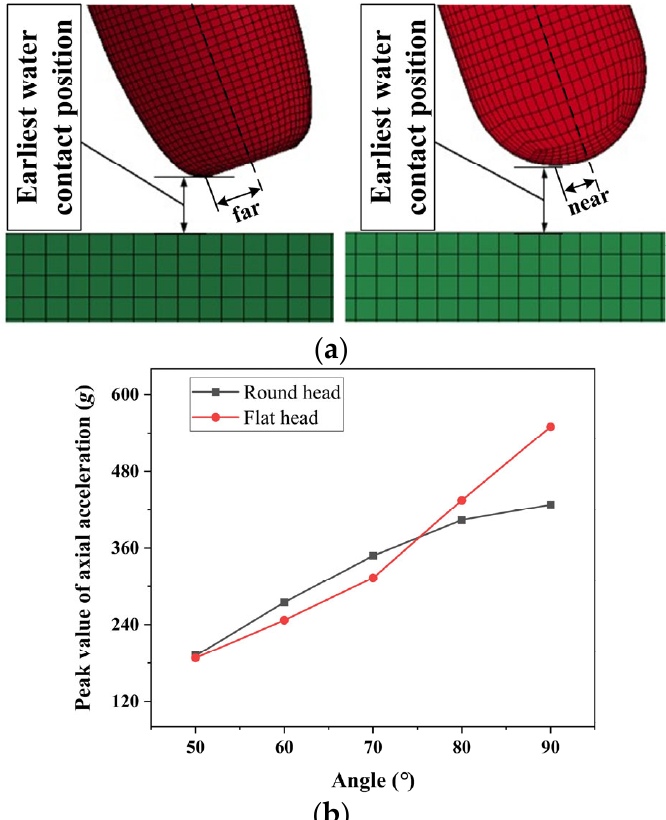
Figure 9. Comparison of two models. ( a ) Water contact positions. ( b ) Peak values.